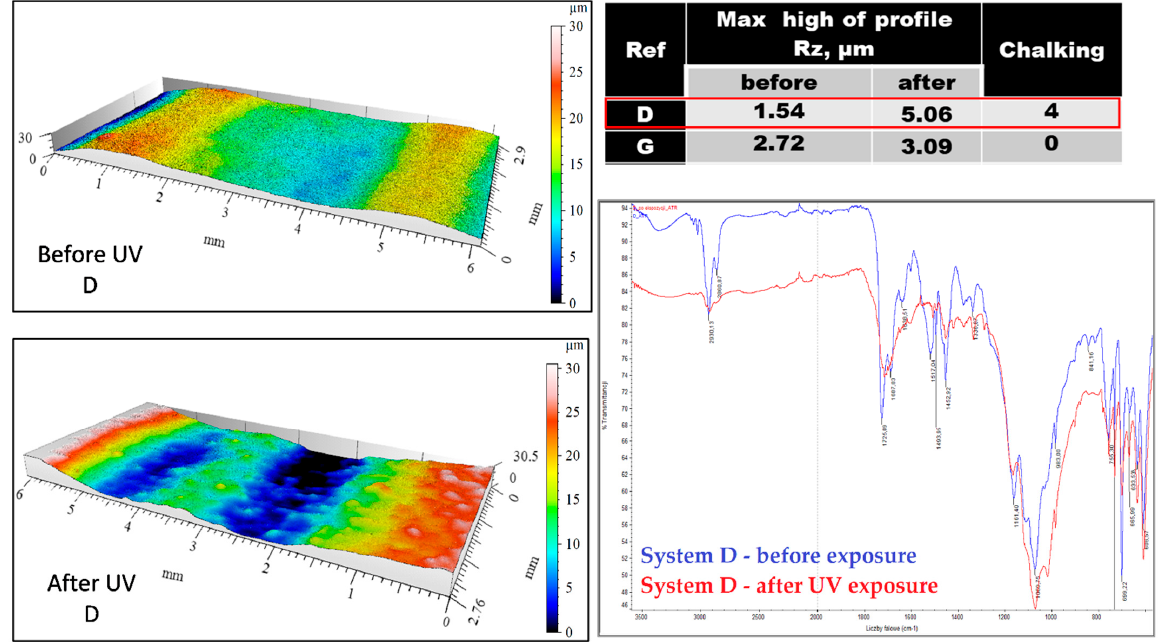
Figure 3. Surface profile and structure of the coating D before and after exposure to UV: greater change in roughness → changes in the FTIR spectrum.